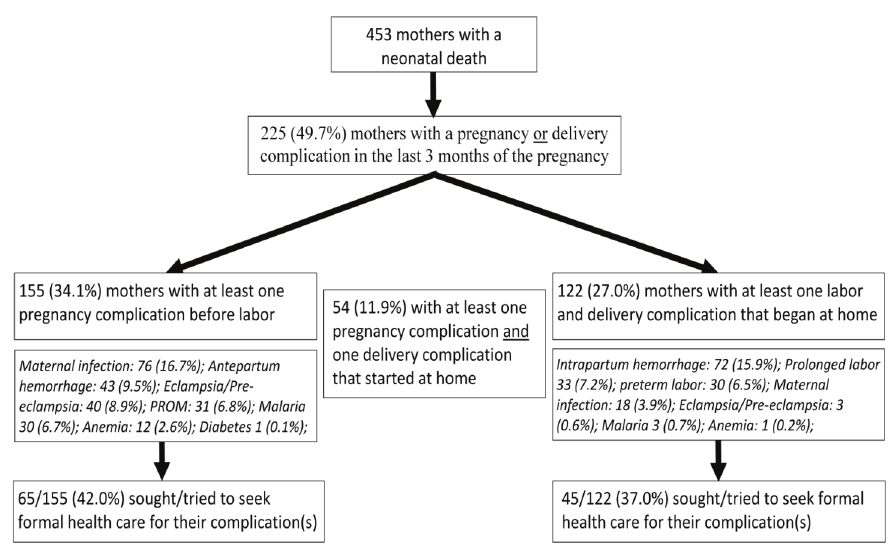
Figure 2. Maternal complications and careseeking during the pregnancy and delivery for 453 neonatal deaths, Niger,